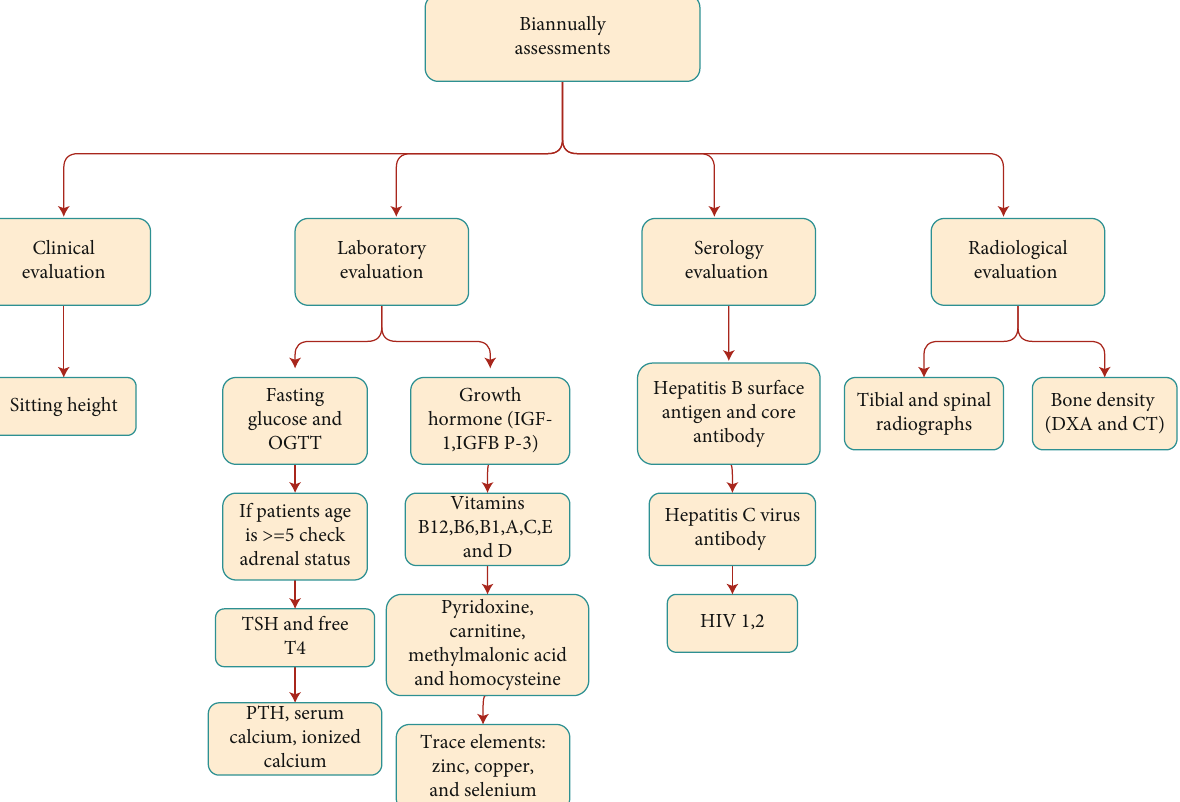
Figure 5: Semantic network representation of follow-up biannual